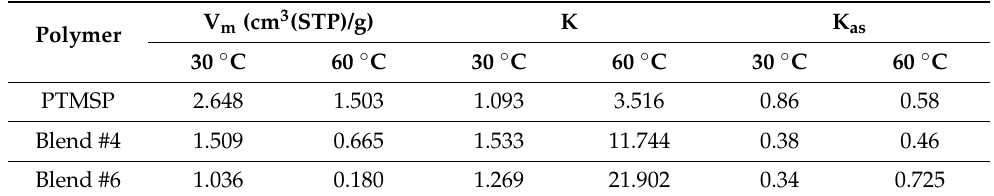
Table 5. Water sorption parameters of Equation (1) for PTMSP and PTMSP/PVTMS blends at 30 ◦ C and 60 ◦